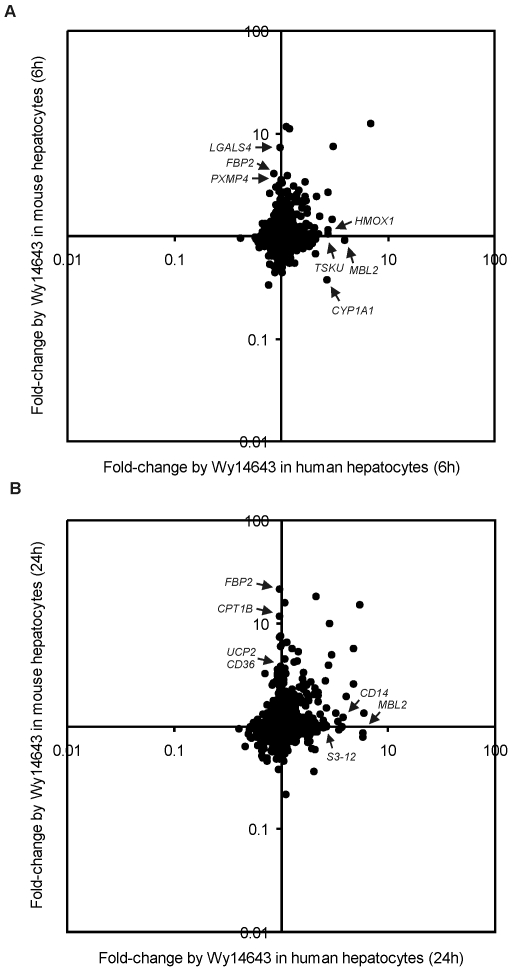
Limited similarity in Wy14643-induced gene regulation between mouse and human hepatocytes.Scatter plots demonstrating similarities and differences in gene regulation by 6 h (A) and 24 h (B) PPARα activation between human and mouse hepatocytes. Graphs show fold-changes in gene expression after treatment with Wy4643 in human hepatocytes (x-axis) and mouse hepatocytes (y-axis). Selected genes that are upregulated specifically by Wy4643 in human or mouse are indicated.